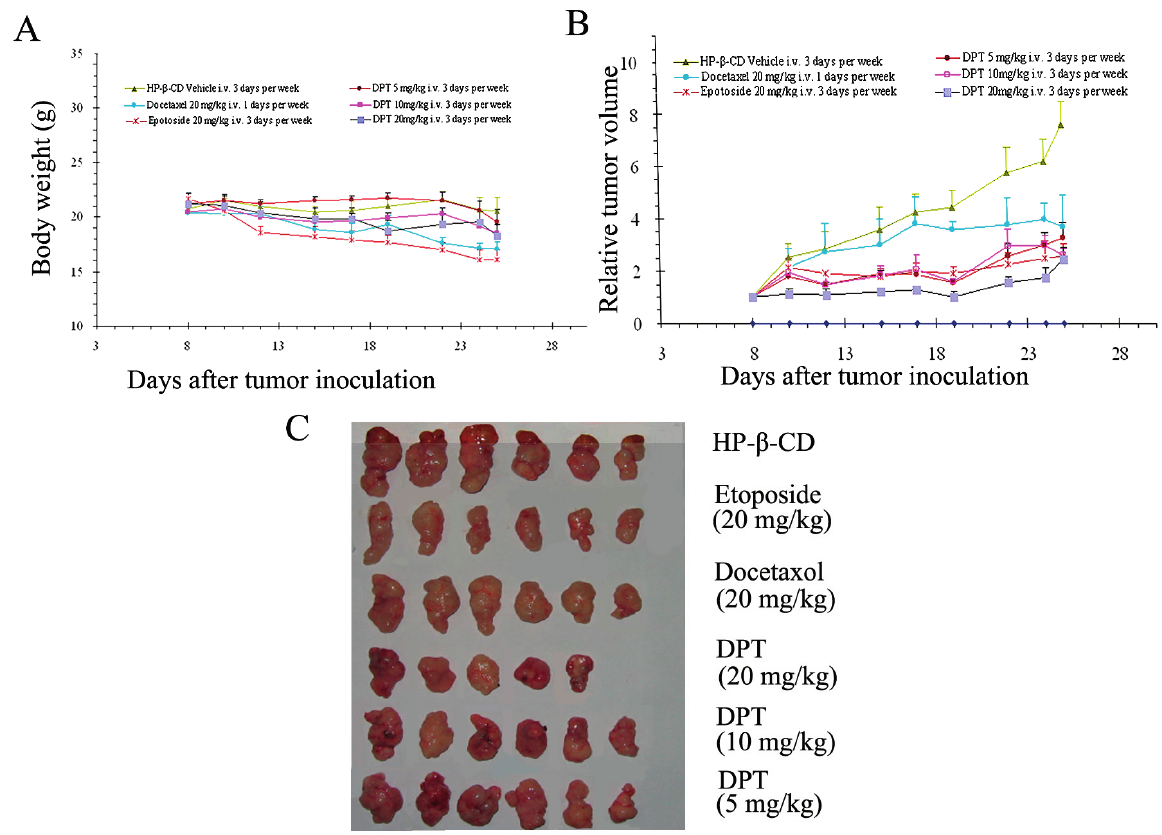
Figure 7. Effects of DPT on the growth of SGC-7901 tumor in nude mice (n = 6). Tumor diameter was serially measured with a vernier caliper, and the relative tumor volume was calculated by the equation described in Section 2. The body weight changes of animals with SGC-7901(xenografts) ( A ) and relative tumor volume ( B ) are shown. Table 1. Inhibitory effects of DPT on the tumor growth of SGC-7901 in nude mice. Group Dosage (mg/kg) Tumor Weight (g) Inhibition Rate (%)